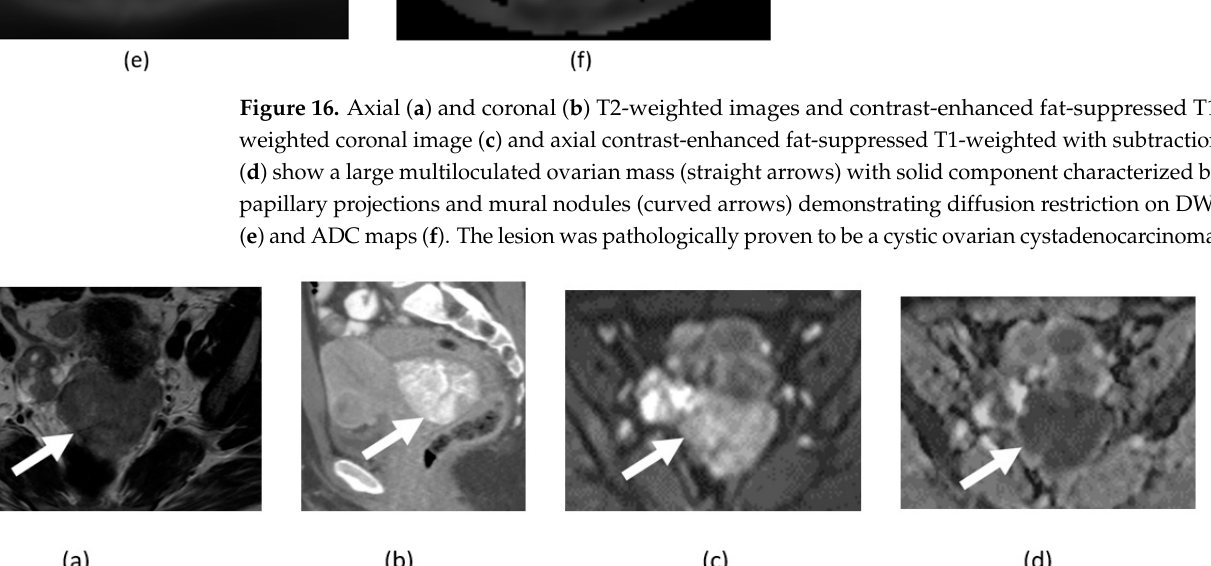
Figure 18. Sagittal T2-weighted ( a ) and T1-weighted FS contrast-enhanced ( b ) images of patient with metastatic endometrial cancer with malignant ascites showing peritoneal thickening and nod- ules showing diffusion restriction in a small endometrial mass from biopsy-proven endometrial cancer (curved arrows) and metastatic peritoneal nodules (arrows) on the sagittal DWI ( c ) and ADC maps ( d ). 5. Pitfalls of DWI DWI has several pitfalls and limitations. Since DWI is intrinsically a T2-weighted se- quence, the DWI signal is affected by the T2 signal. T2 shine-through effect and T2 black- out effects are the two most commonly encountered in clinical practice [1]. 5.1. T2 Shine-Through Effect T2 shine-through effect is described when lesions appear hyperintense on both DWI images and ADC maps (Figure 19). This effect is mainly seen in cystic lesions with higher T2 relaxation times and low b-values. It can be avoided by always correlating DWI images with the corresponding ADC map and using higher b-values (>800) for imaging of the female pelvis [7].